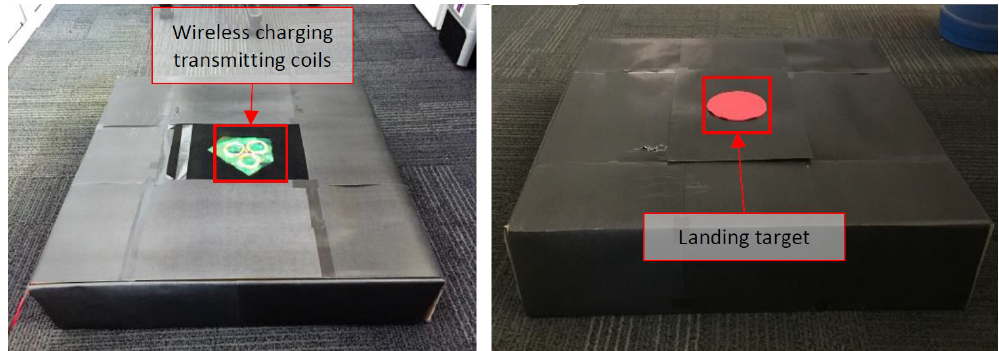
Figure 6. ( Left ) charging station with Transmitter coils; ( right ) red circular target for tracking and landing.